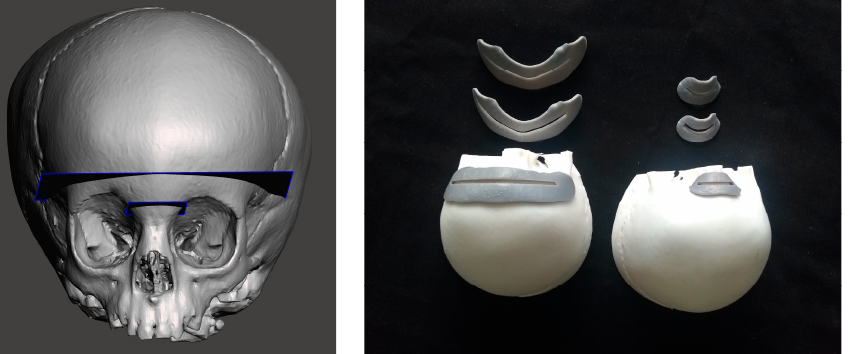
Figure 2. On the left, the planned osteotomies for the fronto-orbital bandeau of the Fronto Orbital Remodeling (FOR) on the right, the 3D printed cutting guides with calibrated grooves for both osteotomies.